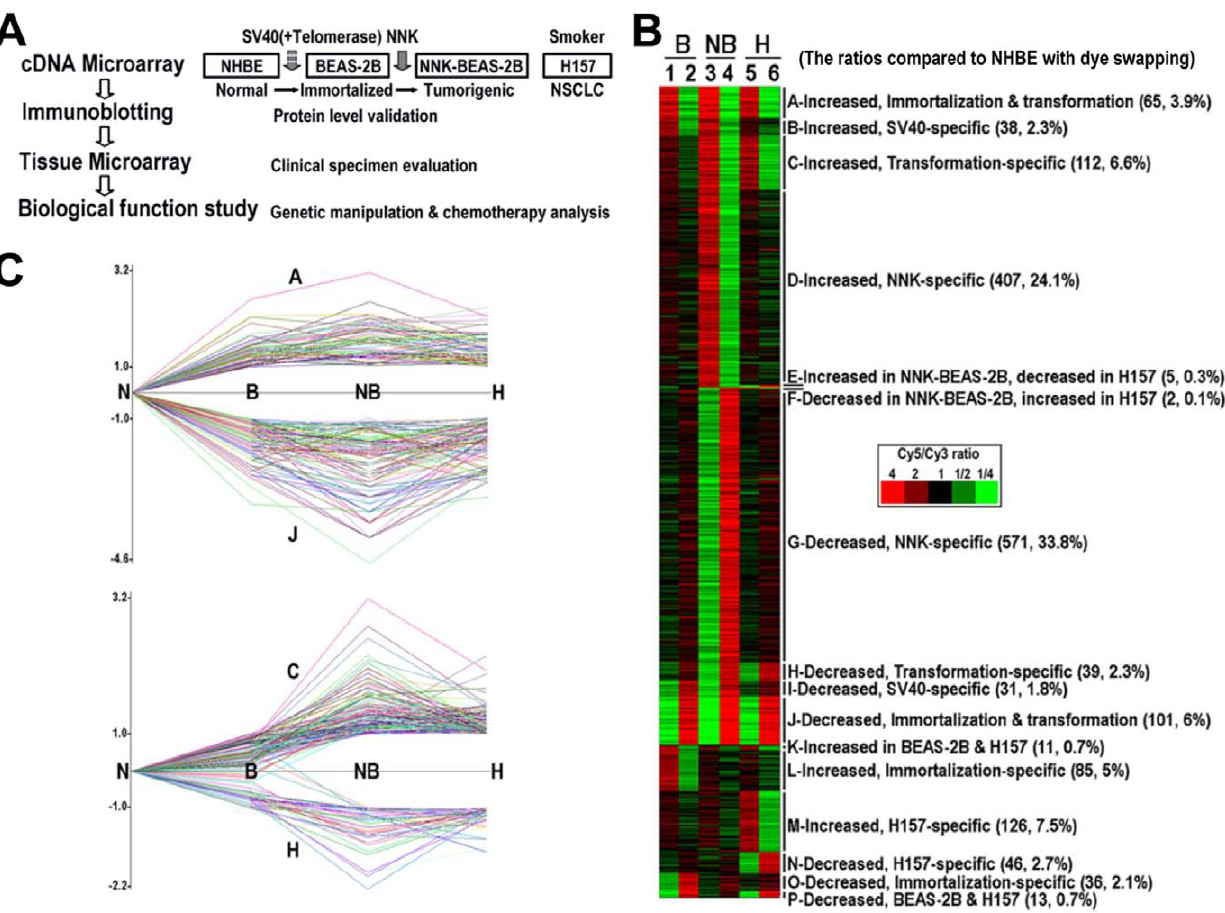
Figure 1. Classification and annotation of differentially expressed genes in BEAS-2B, NNK-BEAS-2B and H157 compared to NHBE. A. The system and strategy to study gene expression profile, its clinical significance and functional role during NSCLC carcinogenesis and chemotherapeutic resistance. B. Classification of 1,688 regulated genes among BEAS-2B (B), NNK-BEAS-2B (NB) and H157 (H) compared to NHBE (N). Genes whose expression level did not change between cell lines were excluded. The ratios graphically visualized by Cluster and TreeView programs (http://rana.lbl.gov/EisenSoftware.htm). Pairs of lanes and reciprocal red and green colors indicate dye swapping. C. Gene expression dynamics during immortalization and/or transformation. The graphs were generated by Cluster Analysis of Gene Expression Dynamics program (http://www. genomethods.org/caged). A, C, J and H symbols depict groups of genes identified in Figure 1B.